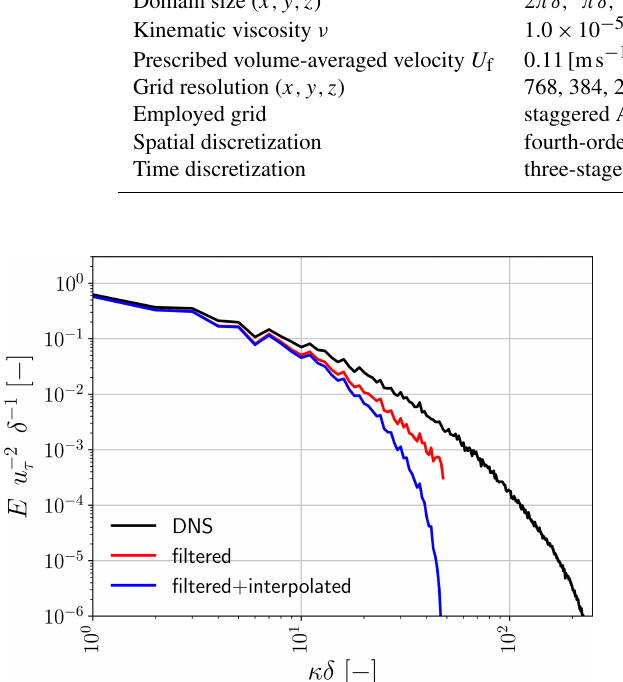
Figure 2. Example stream-wise power spectra of u for the se- lected channel flow (Sect. 3.1) at a height of 0 . 109 δ (i.e. in the log layer) and considering a typical coarse equidistant LES reso- lution of 64 × 32 × 64 ( x × y × z ) cells (which corresponds to a hor- izontal coarse-graining factor of f hor = 8). Here, δ [ m ] refers to the channel-half width. The power spectral density E on the vertical axis has been normalized by δ − 1 and u τ − 2 , where u τ [ ms − 1 ] is the friction velocity. Here, the black line corresponds to the power spectrum of the DNS fields, the red line to the power spectrum re- maining after the finite-volume LES filter (Eq. 2) has been applied, and the blue line to the spectrum remaining after both the finite- volume filter and the second-order linear interpolations required on the coarse LES grid (Eq.